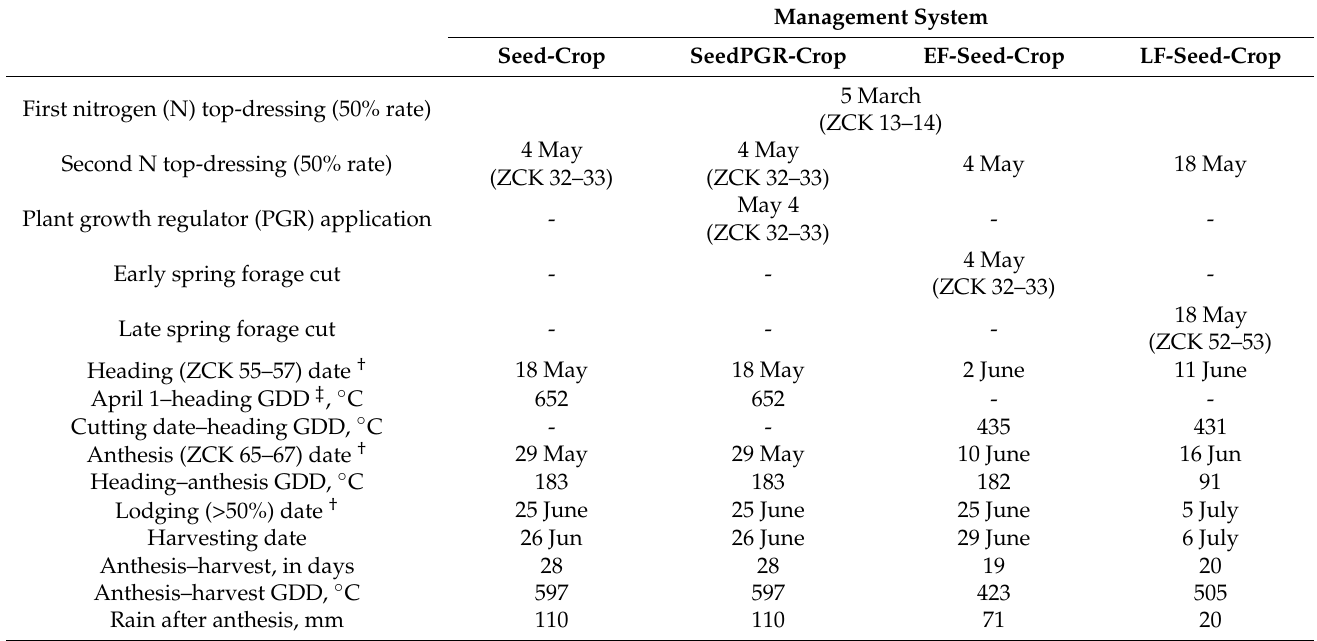
Table 2. Summary of management, growth stages, and weather conditions for the first-production year of biannual Italian ryegrass crop grown for seed